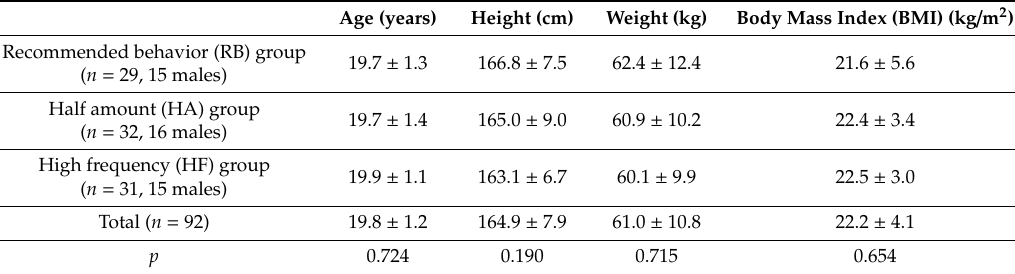
Table 1. The characteristics of the participants.